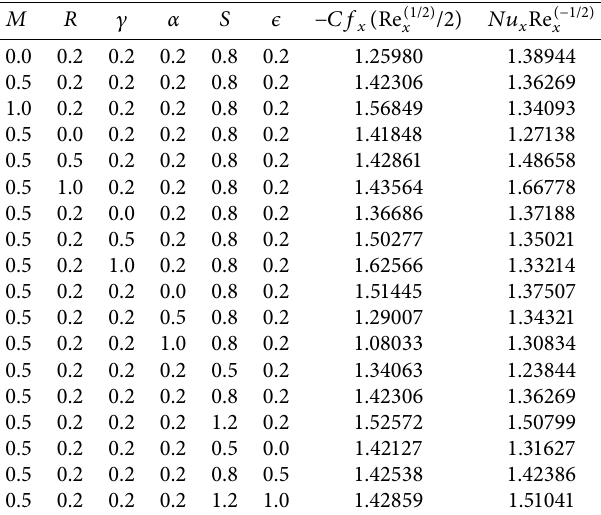
Table 2: Variation of − Cf values of S, α , M, ϵ , c , and R with r � m � Pr �